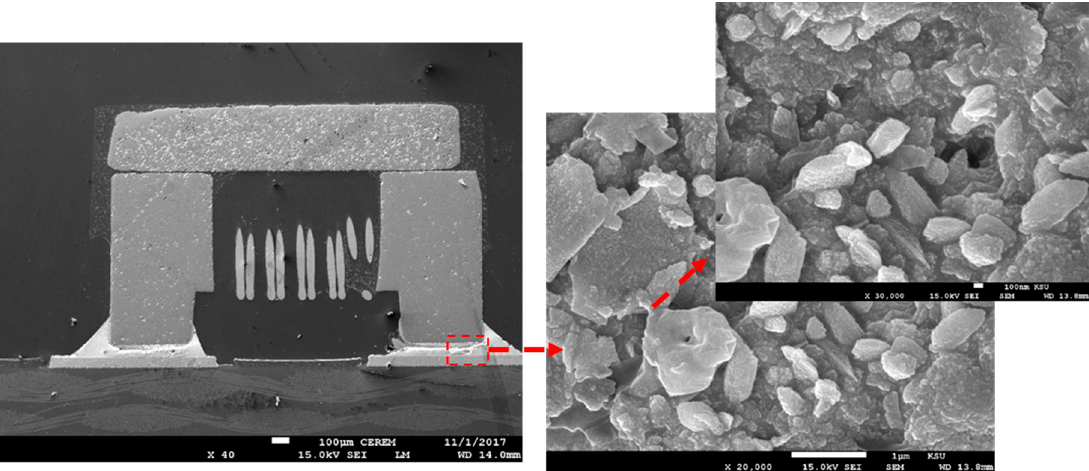
Figure 9. SEM micrograph for the joint interface of a passive component with water washable-nano solder paste.